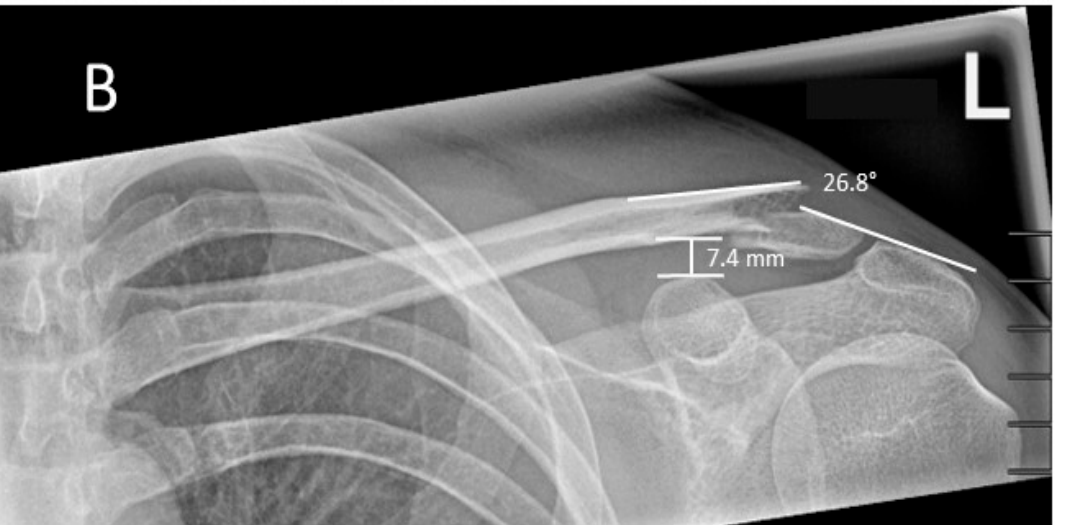
Figure 4. Evaluation method of the fracture angles and CCD in a. p .-X-rays. ( A ) 38-year-old male with Craig IIc fracture. The CCD was 14.5 mm, and the fracture angle was 42°. ( B ) 30-year-old male with Neer I fracture. The CCD was 7.4 mm, and the fracture angle was 26.8°.